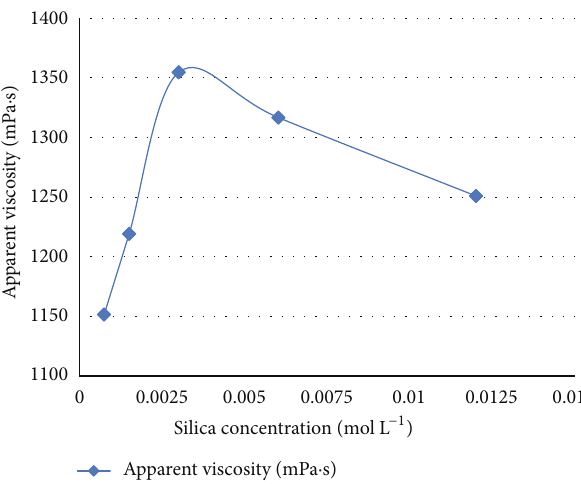
Figure 12: Effect of silica concentration on apparent